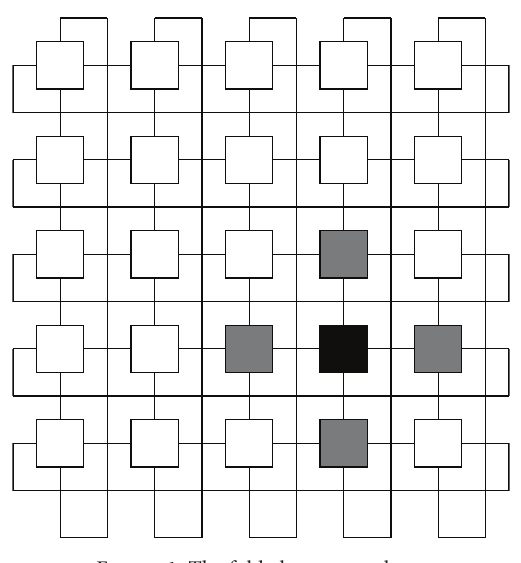
Figure 1: The folded torus